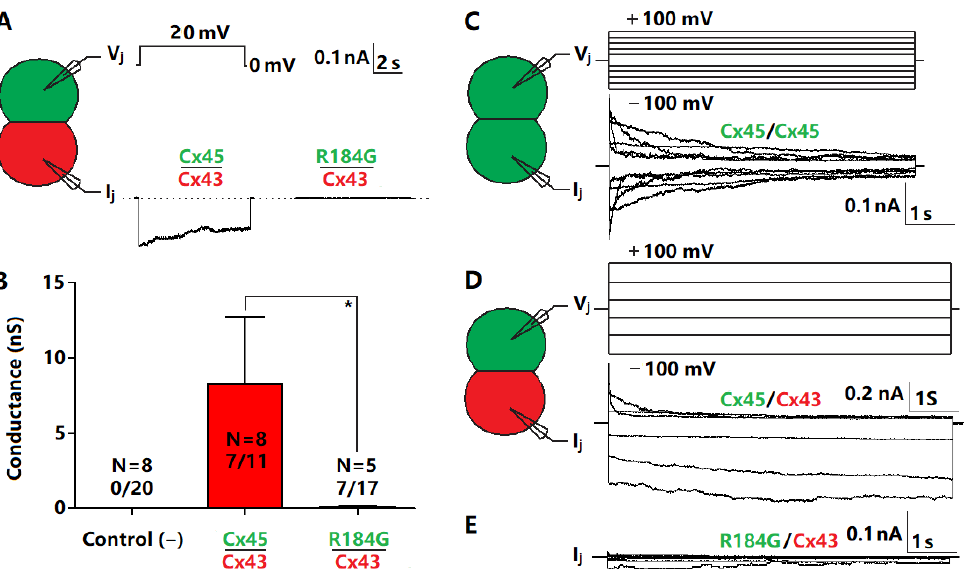
Figure 4. Reduced coupling conductance of heterotypic Cx45 R184G/Cx43 GJ in N2A cells. ( A ) A representative N2A cell pairs with Cx43 expressed in one and Cx45 R184G-mutant expressed in the other showed no trans-junctional current (I j ) in response to V j -pulse, while in a representative cell pair with Cx43 expressed in one and wild-type Cx45 expressed in the other, Ij was recorded. ( B ) Bar graph to show coupling conductance (G j ) of heterotypic Cx45/Cx43 and Cx45 R184/Cx43 GJs. The